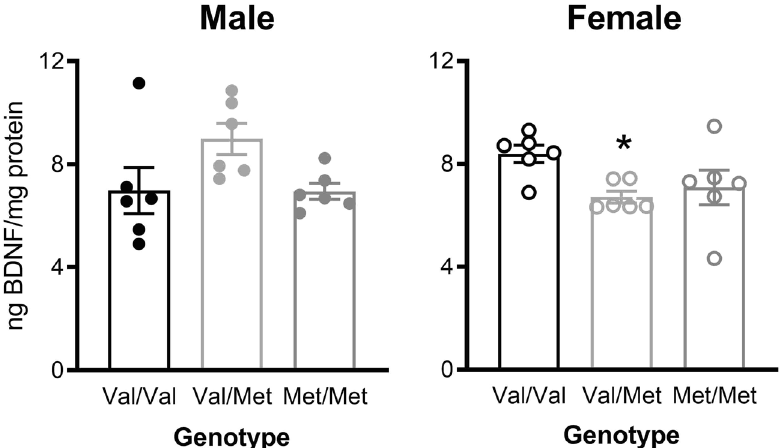
Fig. 5 BDNF levels in the ventral hippocampus as measured by ELISA. Female Val/Met rats showed lower BDNF protein levels than Val/Val controls. Data are presented as mean ± SEM with individual data points for all rats. * p < 0.05 compared to Val/Val